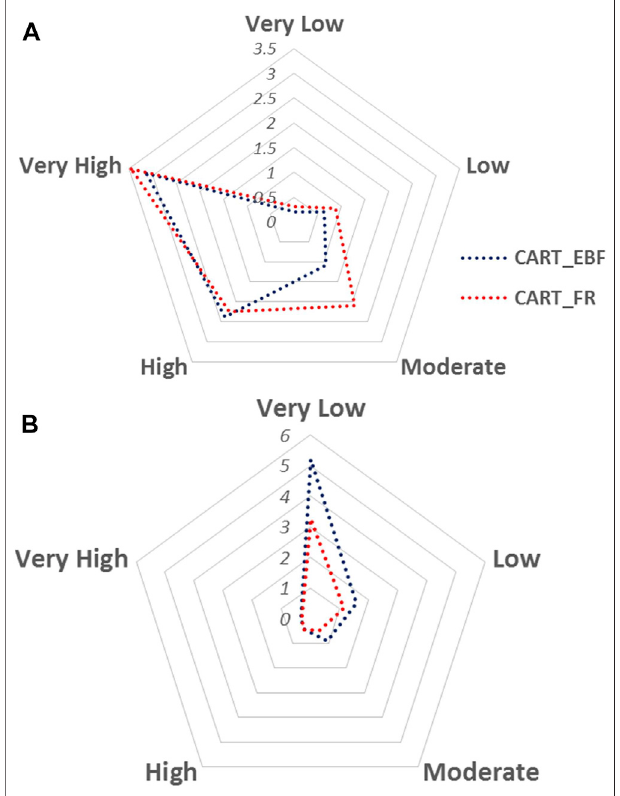
FIGURE8| Ensemblemodelresultvalidationusing: (A) FrequencyRatio Plot (FRP); and (B) Seed Cell Area Index (SCAI)